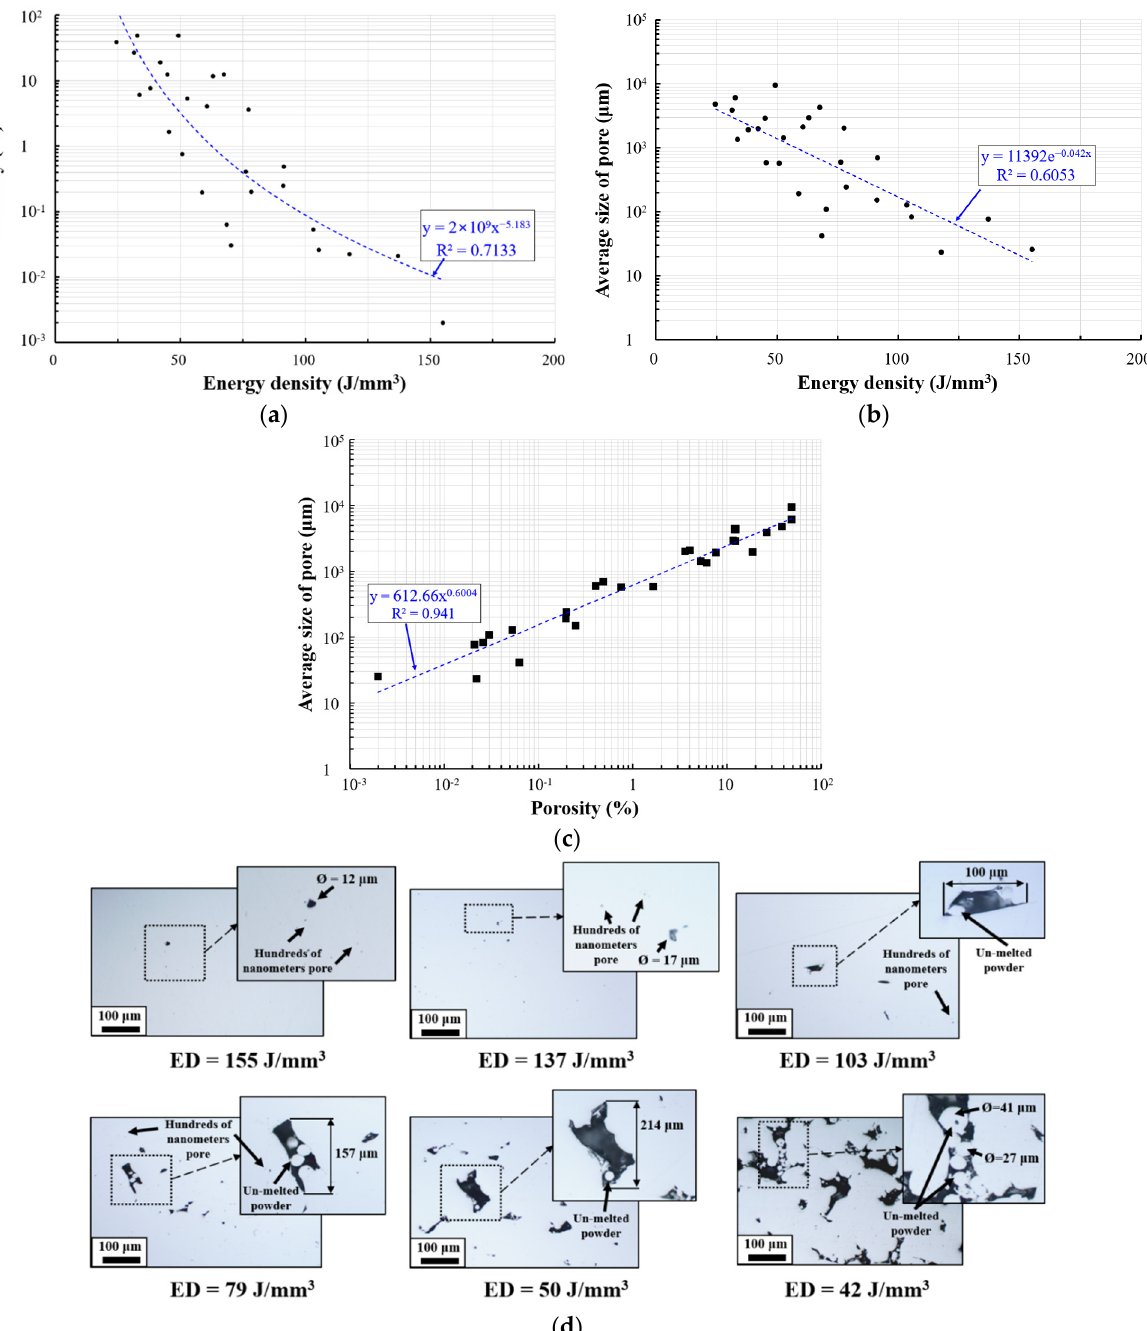
Figure 7. Sectional pore characteristics of deposited specimen for different energy density (J/mm 3 ): ( a ) plot of sectional porosity (%) according to energy density (J/mm 3 ); ( b ) plot of average size of pore (μm) according to energy density (J/mm 3 ); ( c ) plot of average size of pore (μm) according to porosity (%); and ( d ) morphology of the internal pore according to the energy density (J/mm 3 ).